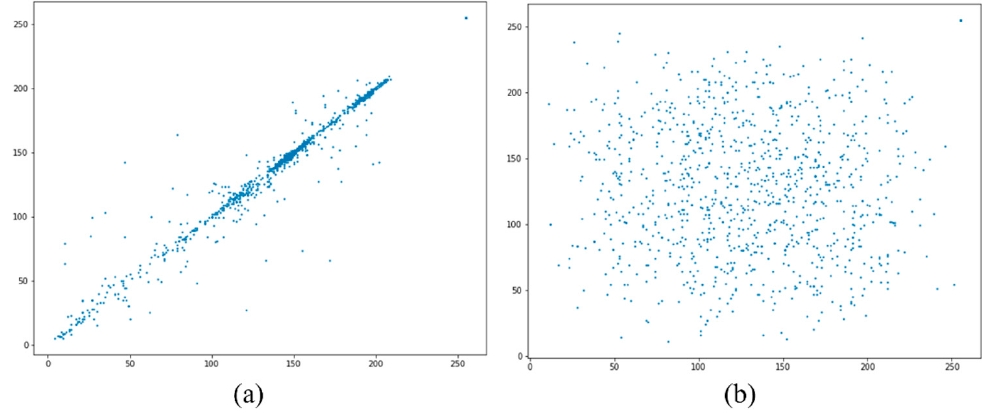
21 of 26 Figure 9. Histograms of original and encrypted image frames. ( a ) represents the original sample image frame, ( b ) depicts the histogram of the original image while ( c ) represents the encrypted im- age frame, and ( d ) is the depiction of the histogram of the encrypted image frame.